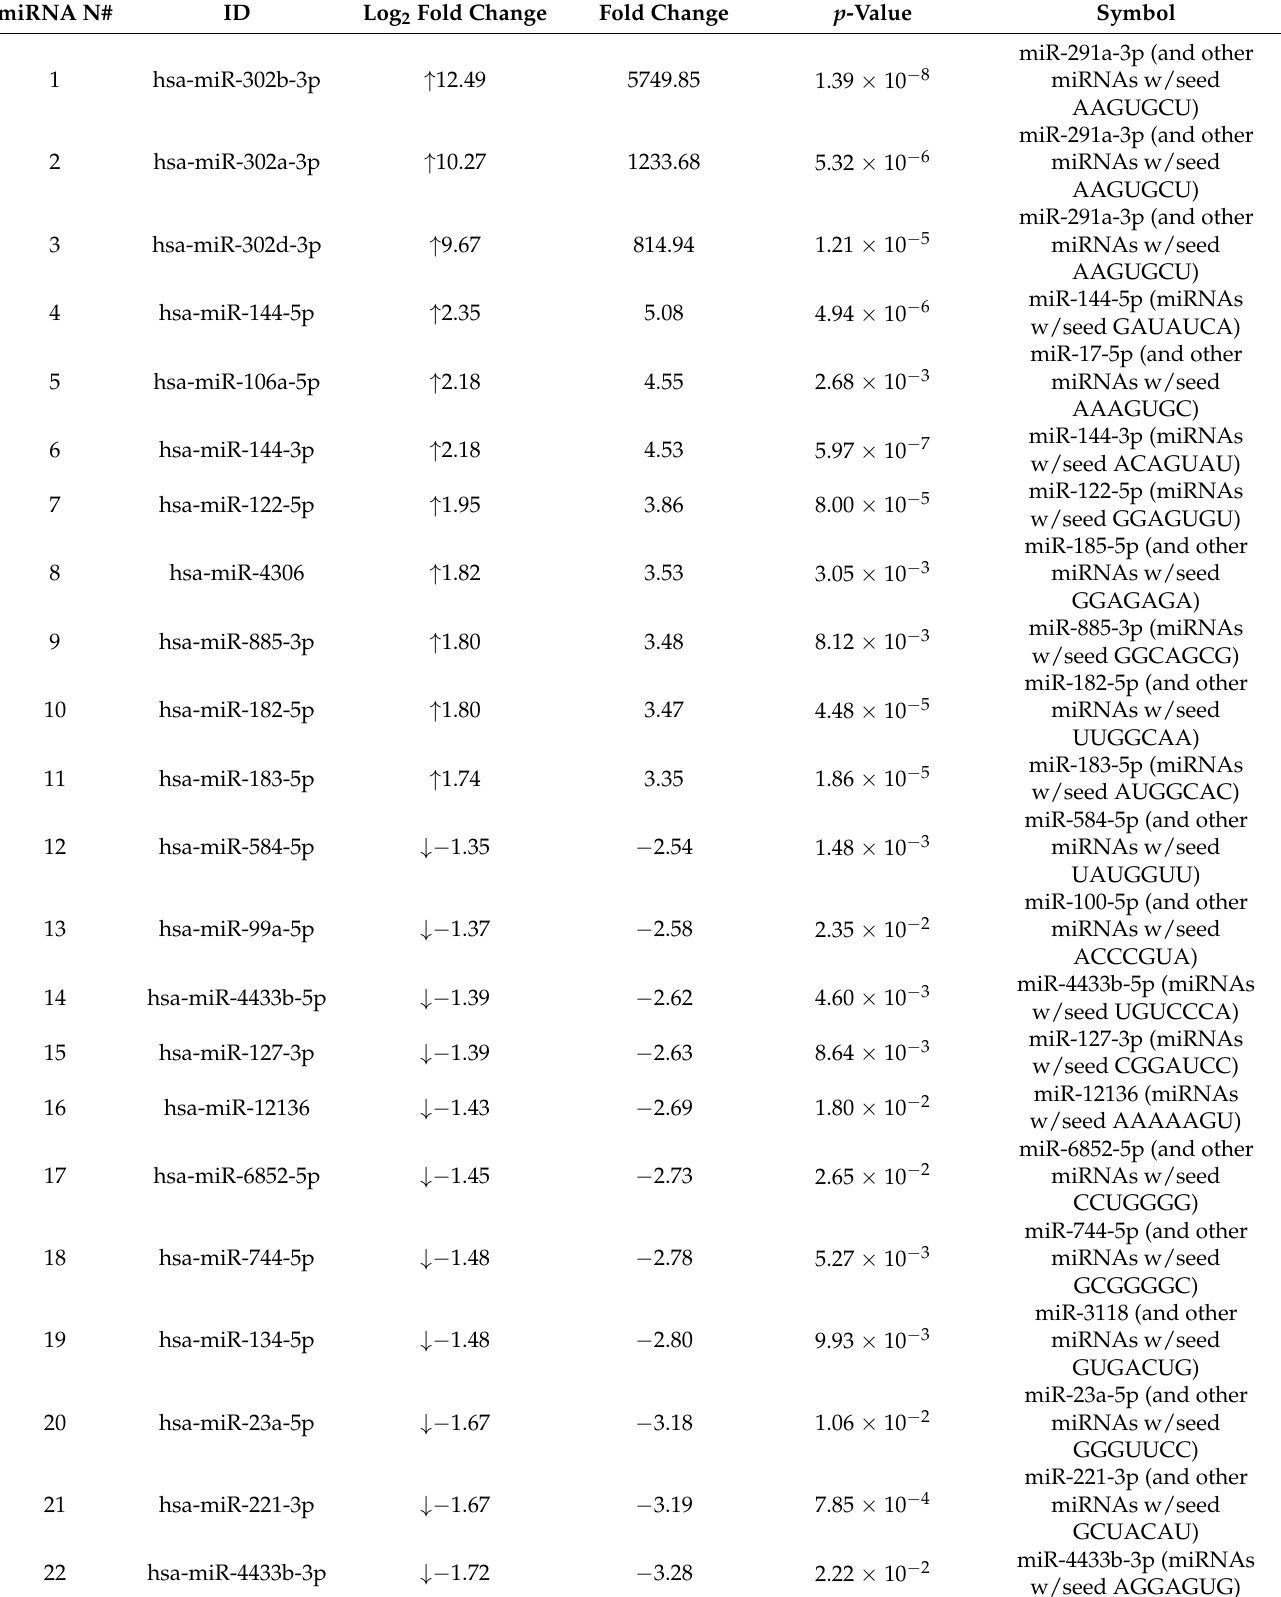
Table 4. The most differentially expressed miRNAs between ASD vs. Control (Absolute fold change > 2; p < 0.05). miRNA